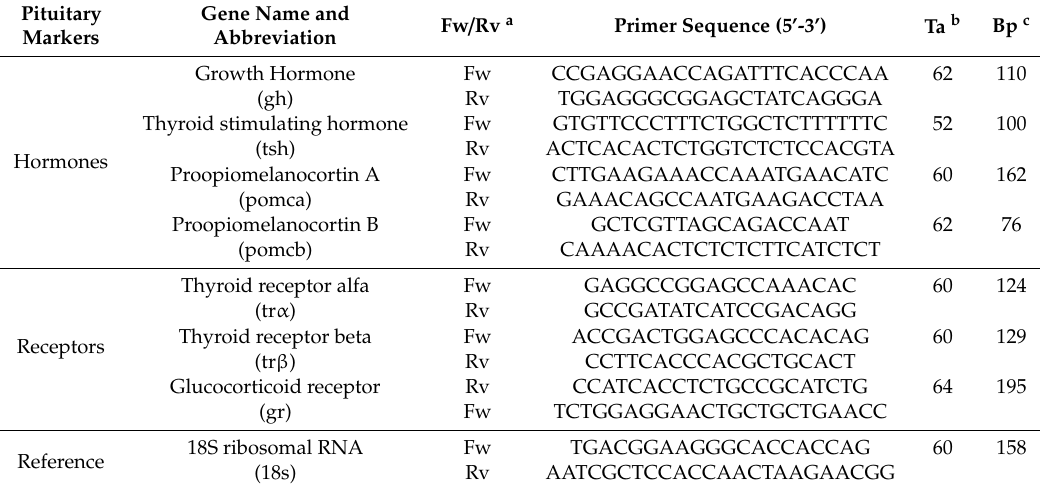
Table 2. List of the amplified genes and the primers used for analysis of gene expression by quantitative